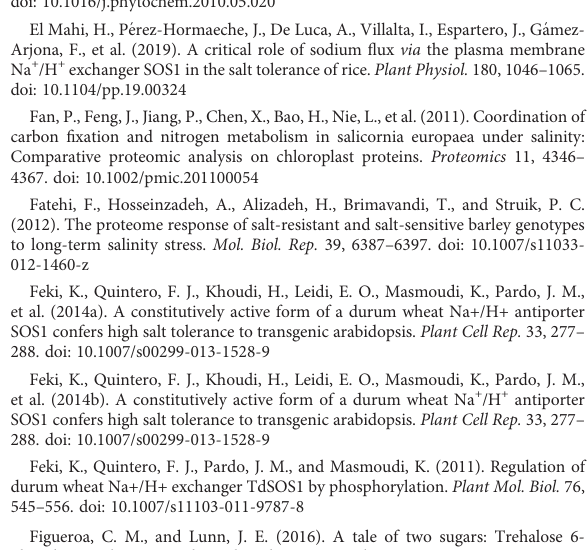
Figueroa, C. M., and Lunn, J. E. (2016). A tale of two sugars: Trehalose 6- phosphate and sucrose. Plant Physiol. 172, 7 – 27. doi: